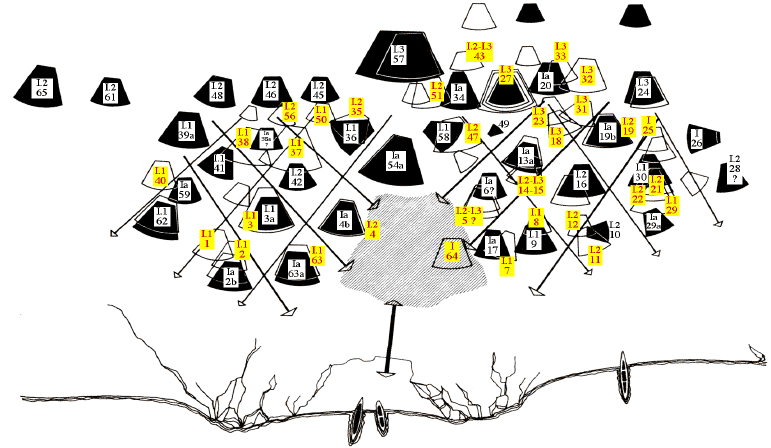
Figure 20. The basic flows of communication in Lepenski Vir, as an excellent proof that urban planning is a science that is much older than it is usually considered. From the time of its creation, man constantly tries to ease everyday life. The best way to provide yourself and the offspring with everything you need is to settle down in a favourable place. And that means near food, for hunting and gathering, far from possible attackers, other hostile tribes, and dangerous animals. At the same time, care should be taken of weather conditions, that they are not too harsh, neither the passionate winter nor the overly dry summer. If there is no room and no disposal is just a natural cave or similar, then we are satisfied with what we have. If we find a suitable place that has all the present capacities and at the same time enough space for our construction, then we begin to apply the knowledge which we can shortly call - urbanism. The planned construction starts. First, the most suitable spaces are taken and those that can be easily reached. It is possible to provide facilities near the coast, or on an elevated surface and the like. Here we can see that our ancestors greatly watched everyone have some good conditions. Everyone was connected by footed streets. Everyone had their privacy as much as possible. It was planned for the benefit of all, those who first built their houses and those that will come later.